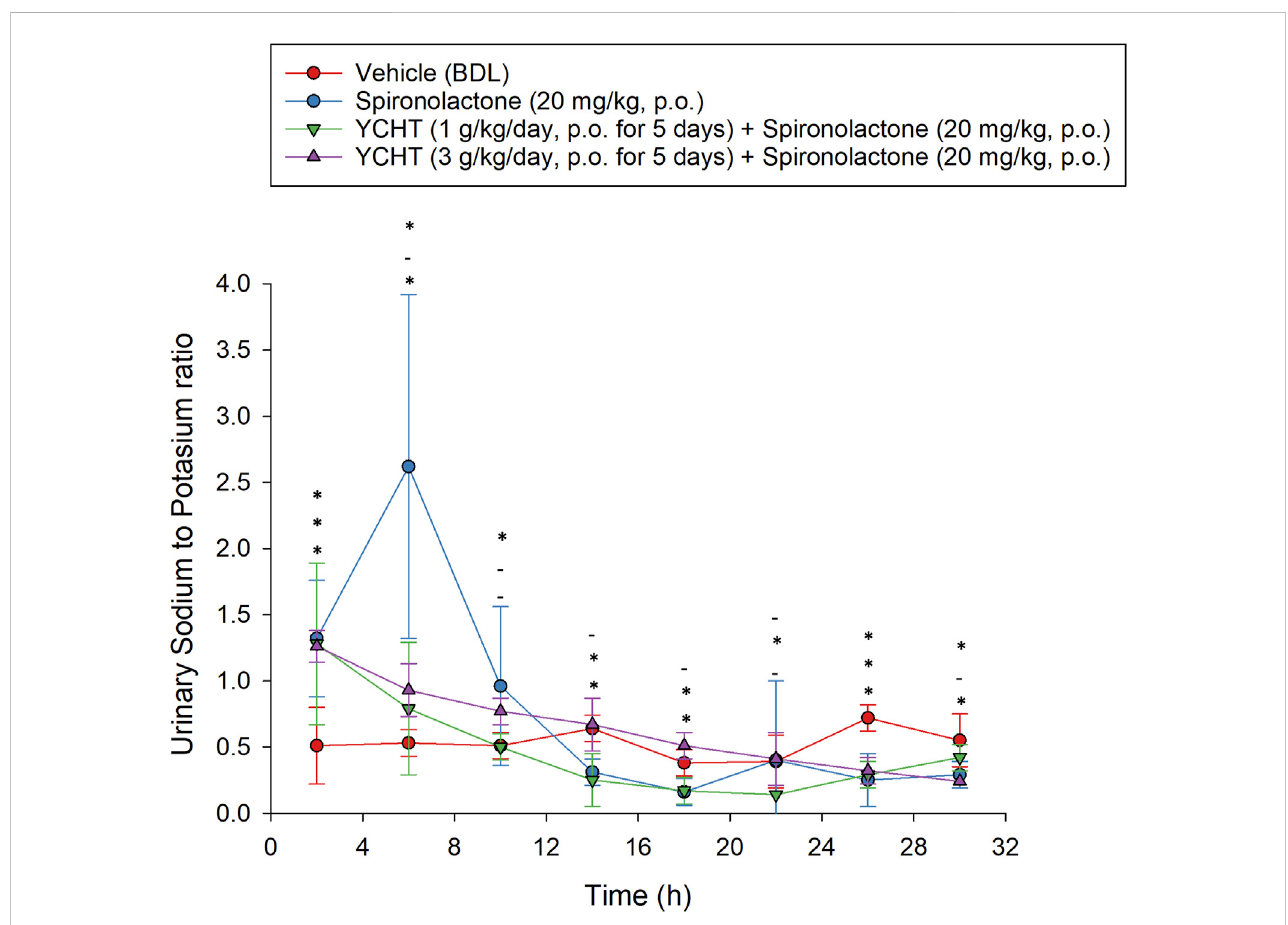
FIGURE 6 Urinesodium-to-potassium ratioafter thesingle oral administrationofspironolactone ineachgroup. Symbolsfromthebottom to thetoprepresent the spironolactone, 1 g/kg YCHT with spironolactone, and 3 g/kg YCHT with spironolactone groups. *Signi fi cance ( p -value < .05) compared with the vehicle group; - indicates no signi fi cance compared to the vehicle group. Data were signi fi cantly different by t-test. YCHT,